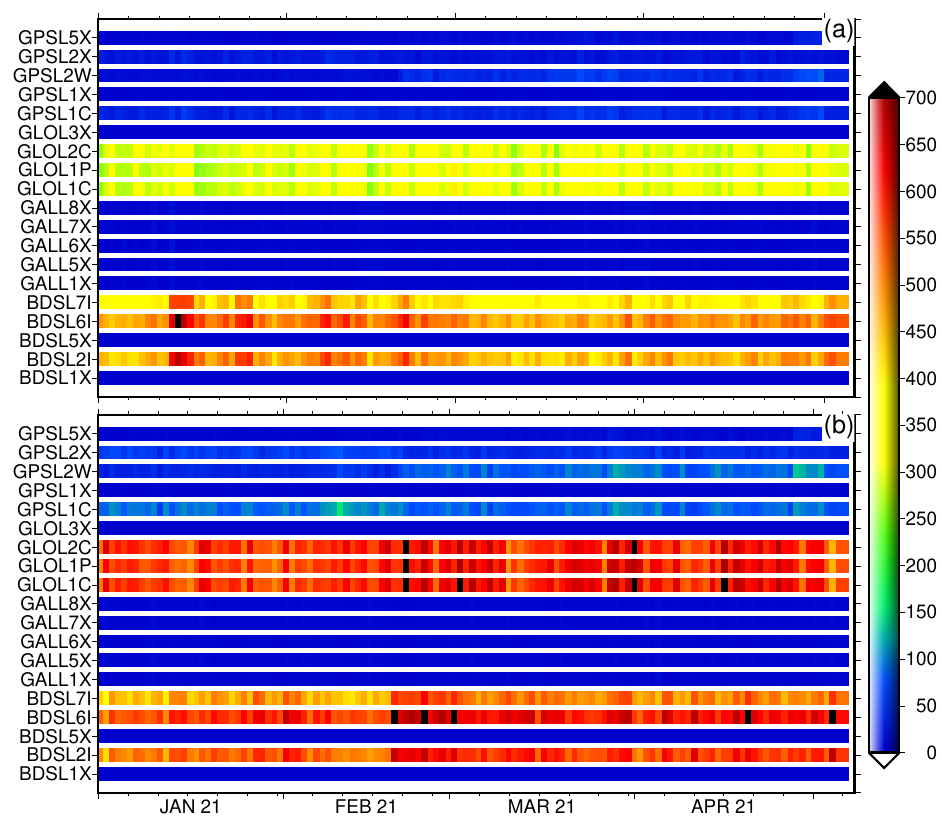
Figure 7. The number of identified real phase cycle-slips during continuous phase tracking for station KBG1 with Eccosorb ( a ) and for station KBG2 without Eccosorb ( b ) for the period January 2021